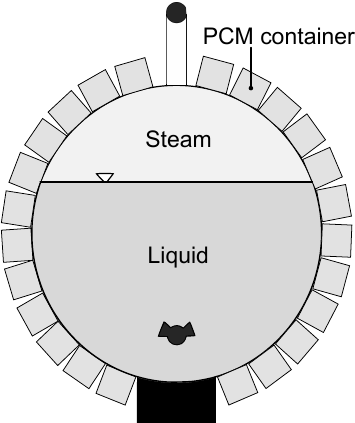
Figure 6. Schematic sketch of the hybrid storage design consisting of the RSS and the surrounding LHTES modules [43].